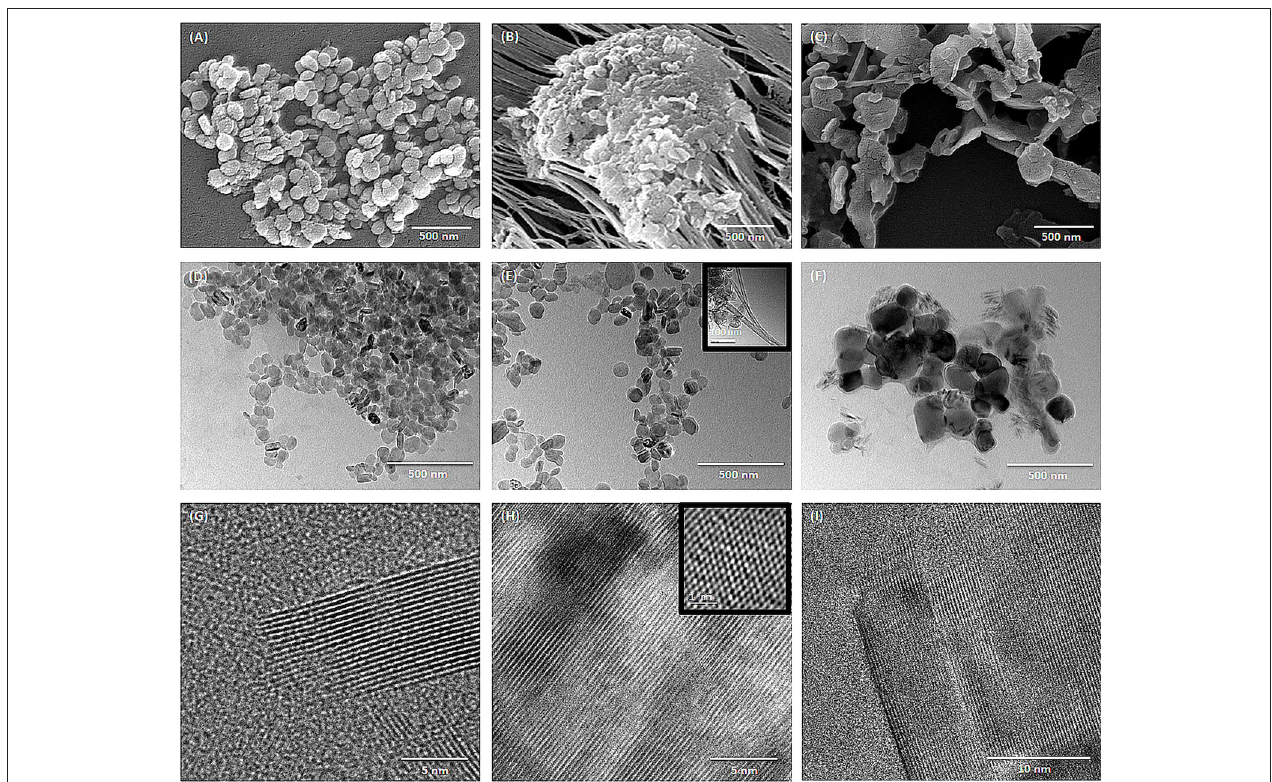
FIGURE 1 | SEM images of (A) hBNs_boric acid, (B) hBNs_colemanite, and (C) hBNs_boron trioxide. TEM images of (D,G) hBNs_boric acid, (E,H) hBNs_colemanite, and (F,I) hBNs_boron trioxide.